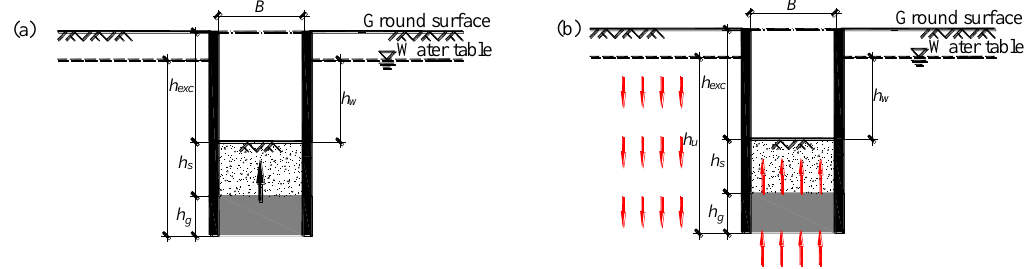
Figure 2. Failure mechanisms of jet-grouted bottom sealing barriers: ( a ) Instability failure; ( b ) Seepage failure.